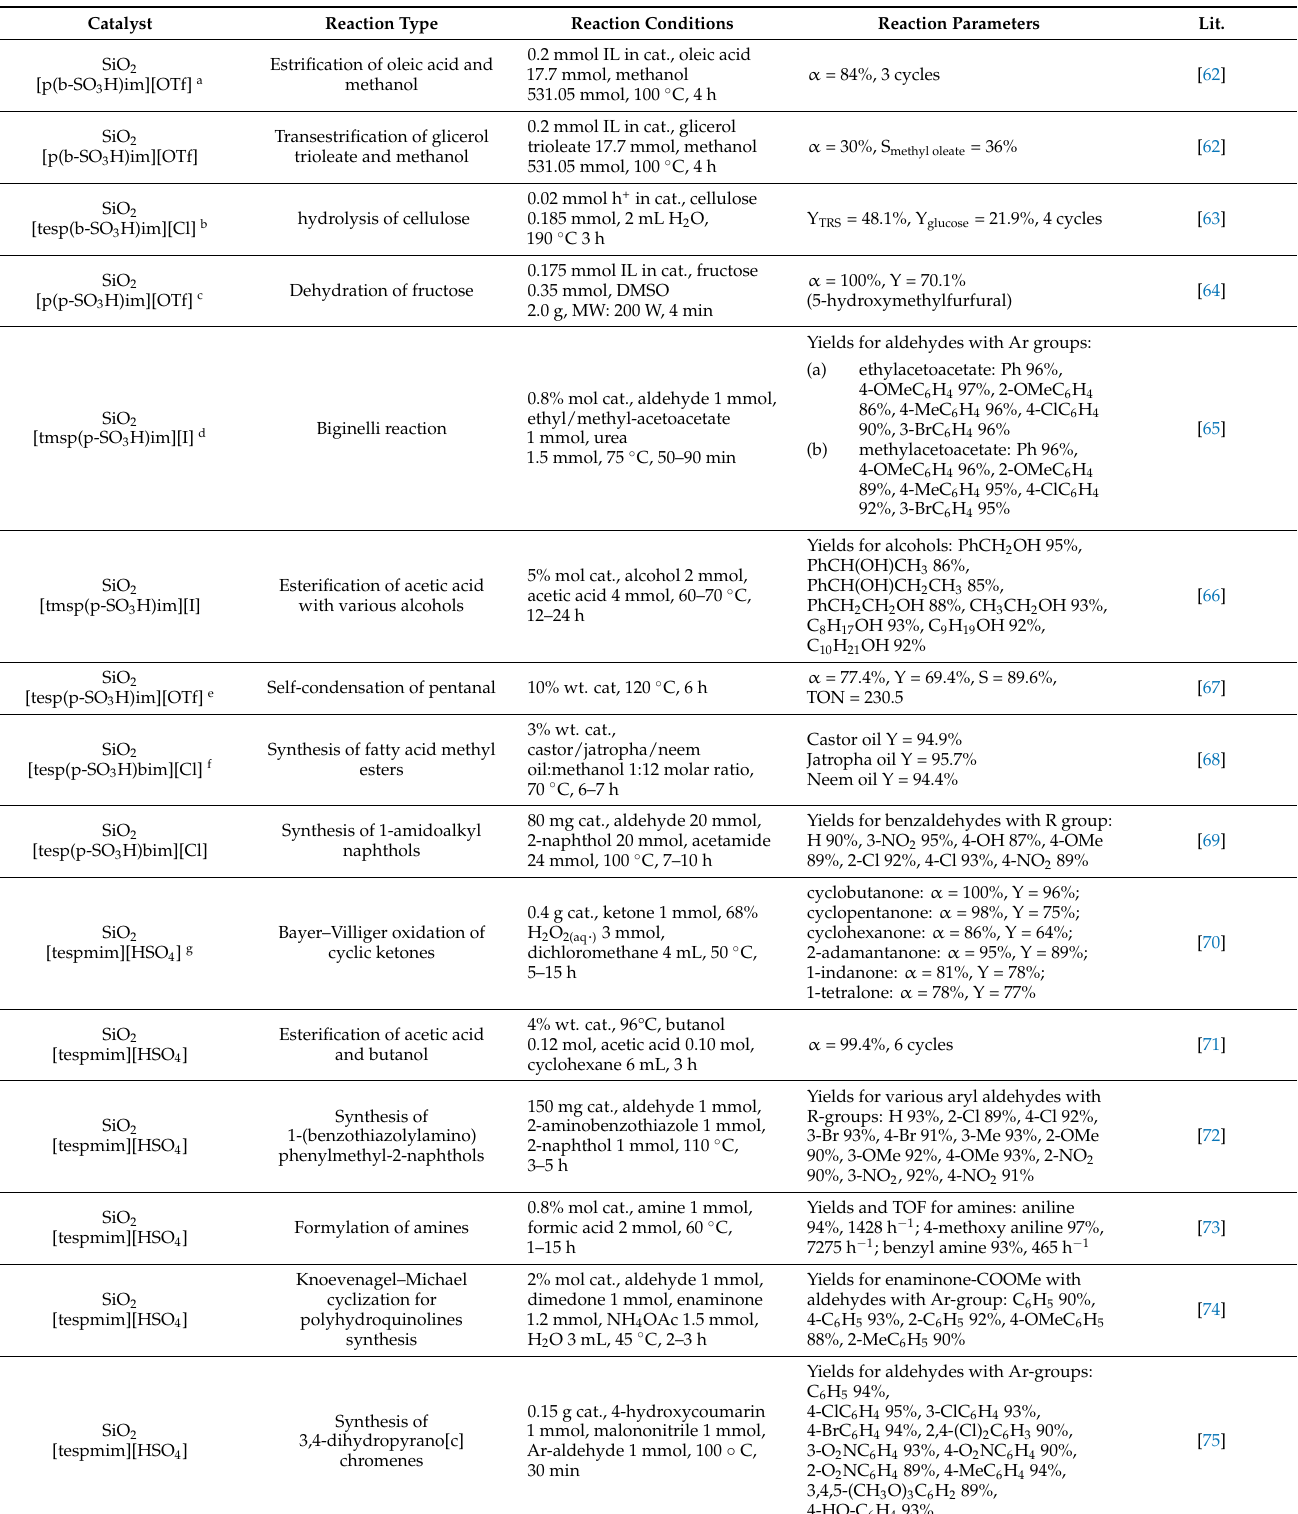
Table 2. Brønsted-type silica-based SILLP in organic